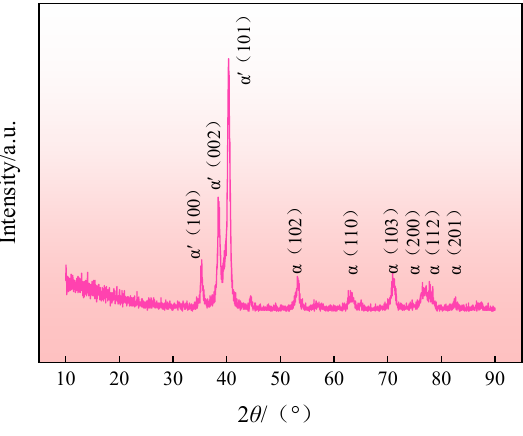
Figure 10. XRD pattern of WM.